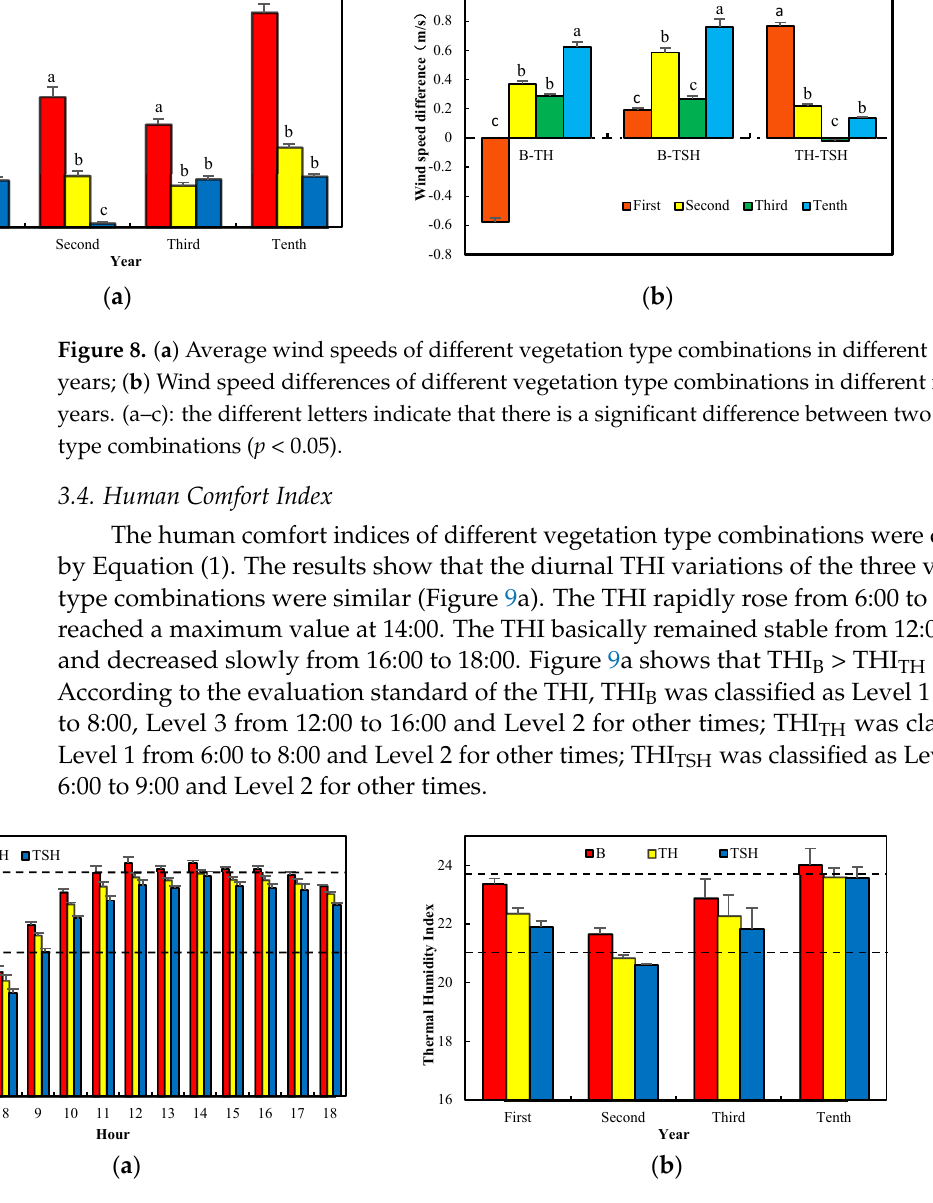
Figure 9. ( a ) THI variations for each hour in different vegetation type combinations; ( b ) Average THI of different vegetation type combinations in different restoration years.